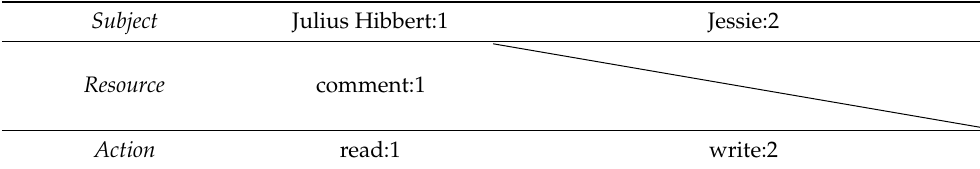
Table 2. An Example of Numerical Values of